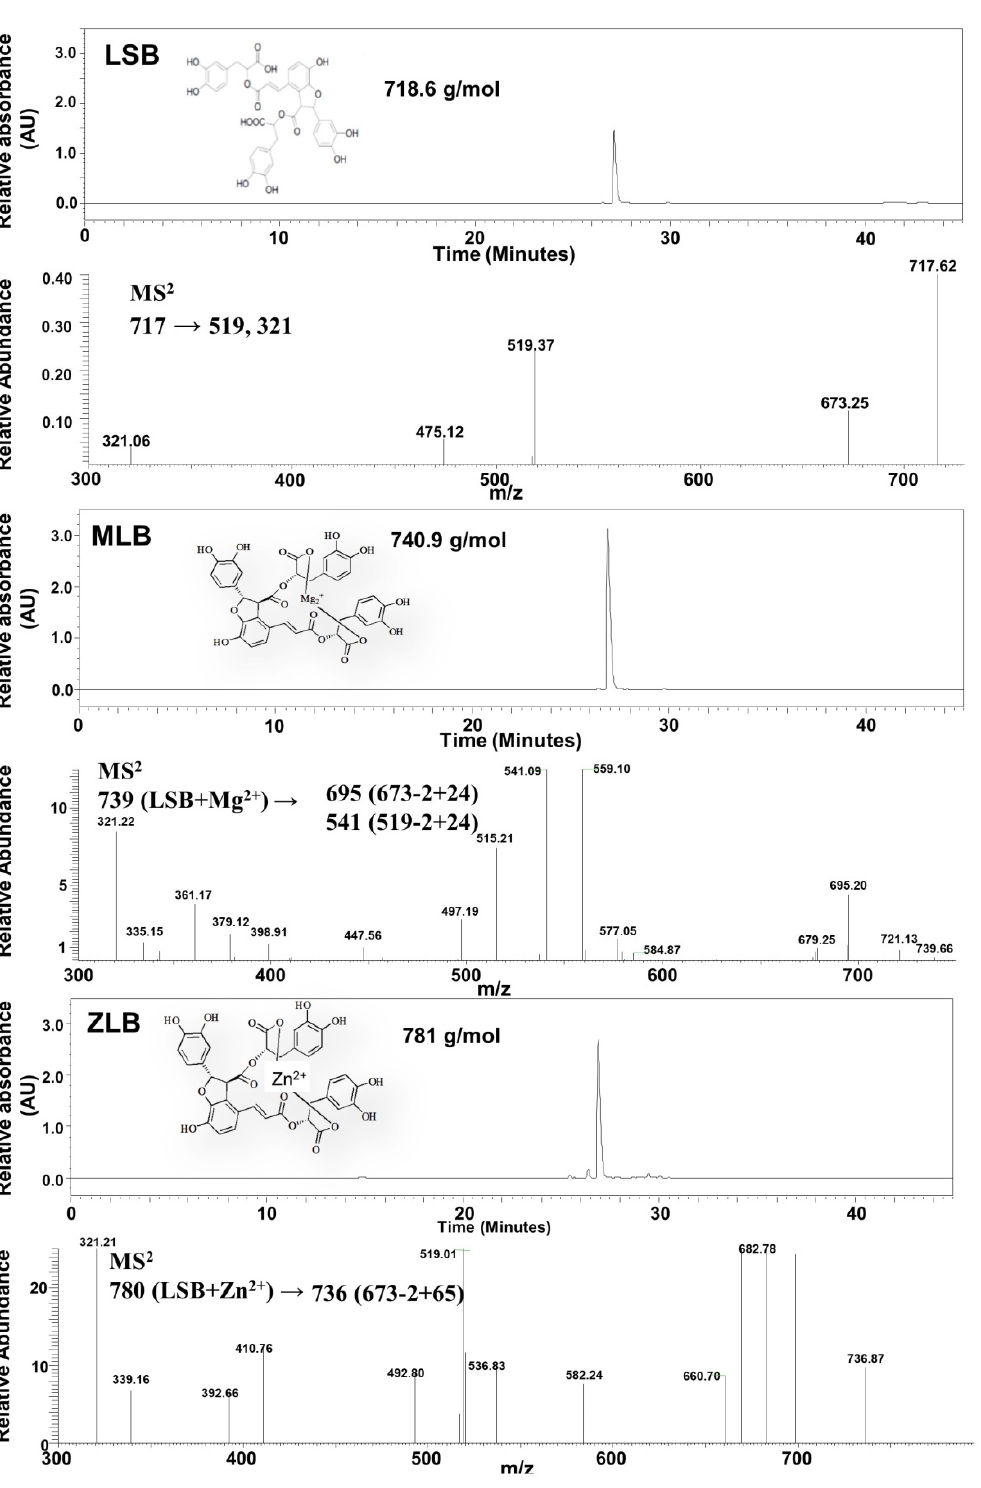
Figure 1. Identification of magnesium lithospermate B (MLB) and zinc lithospermate B (ZLB) by HPLC and LC − MS. Lithospermate B (LSB), MLB, and ZLB were detected by HPLC spectrum at 280 nm and confirmed by mass spectrometric analyses on the basis of fragmentation patterns of LSB published previously [24,25].